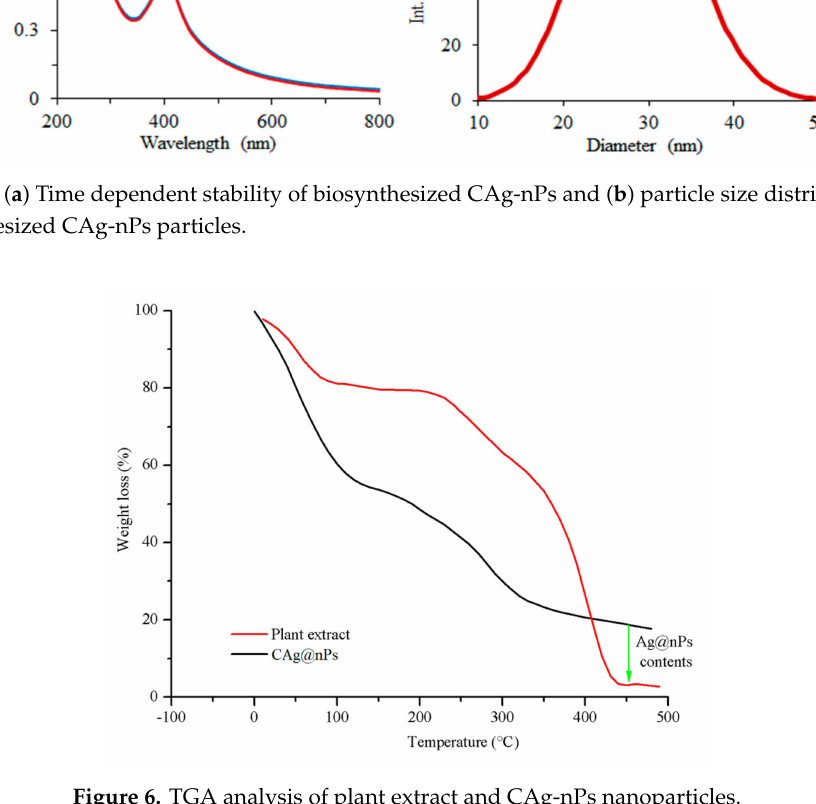
Figure 6. TGA analysis of plant extract and CAg-nPs